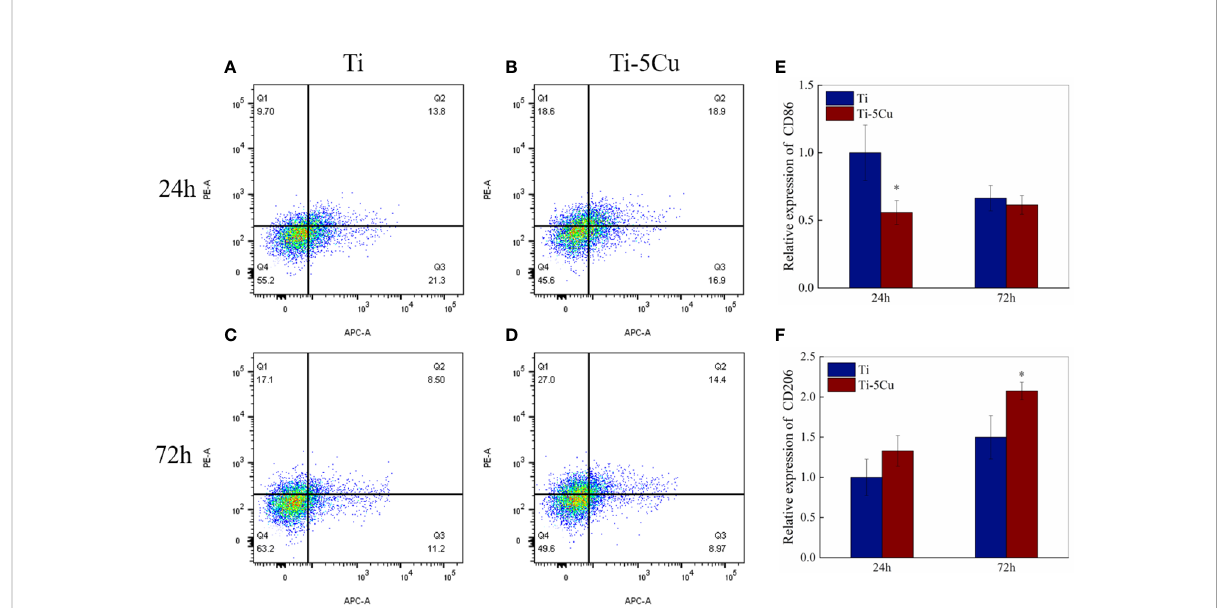
FIGURE 4 The expressions of CD86 and CD206 in RAW264.7 cells co-cultured with Ti and Ti-5Cu alloy at 24 and 72 h by fl ow cytometry and RT-qPCR. (A) Ti at 24 h ; (B) Ti-5Cu at 24 h ; (C) Ti at 72 h ; (D) Ti-5Cu at 72 h ; (E) the gene expressions of CD86; (F) the gene expressions of CD206 (n = 3; *p <